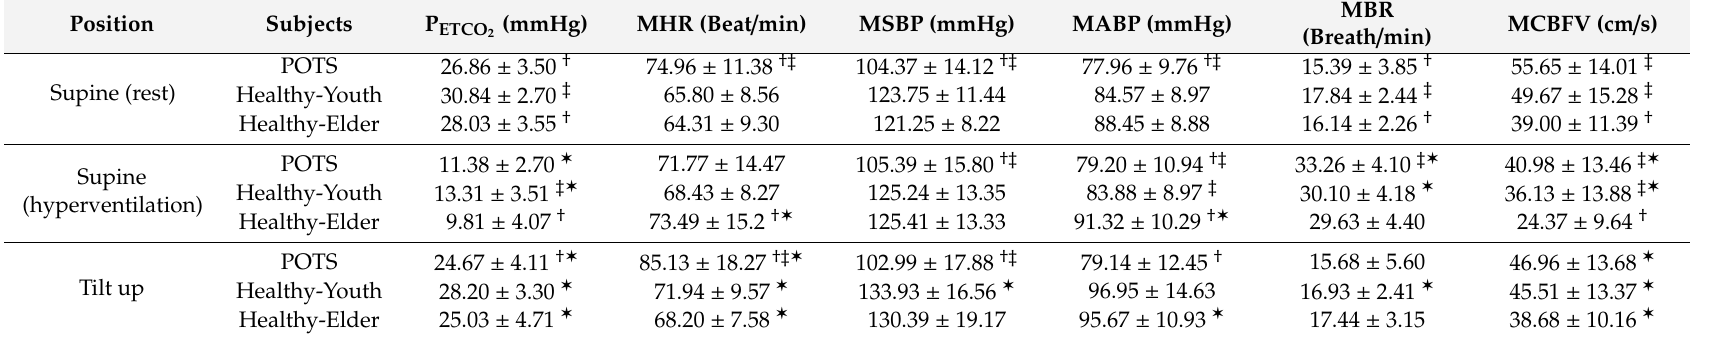
Table 2. Mean values of cardio-respiratory signals for three subject